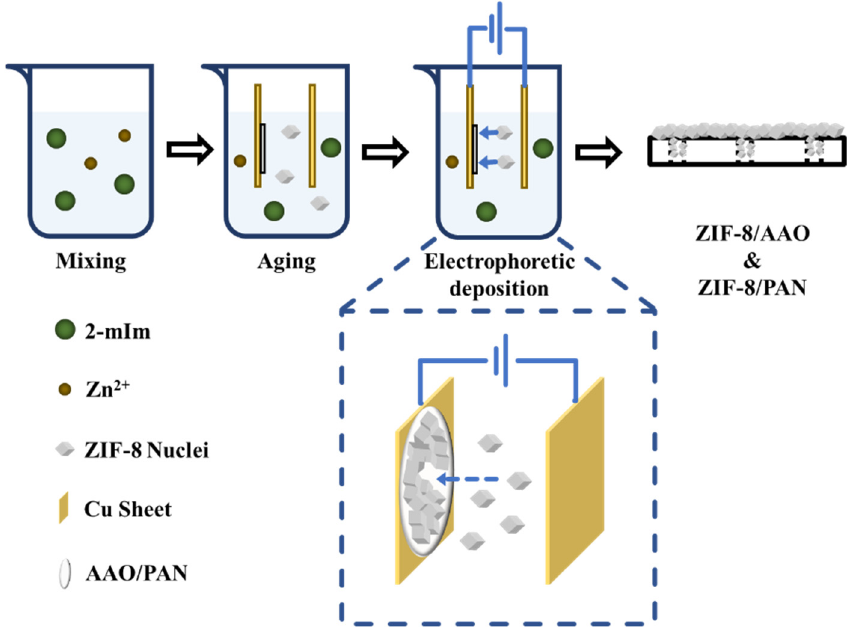
Figure 1. Schematic diagram of the preparation process of ZIF-8 membrane with electrophoretic deposition method (2-mIm: 2-methyimidazole). deposition method (2-mIm: